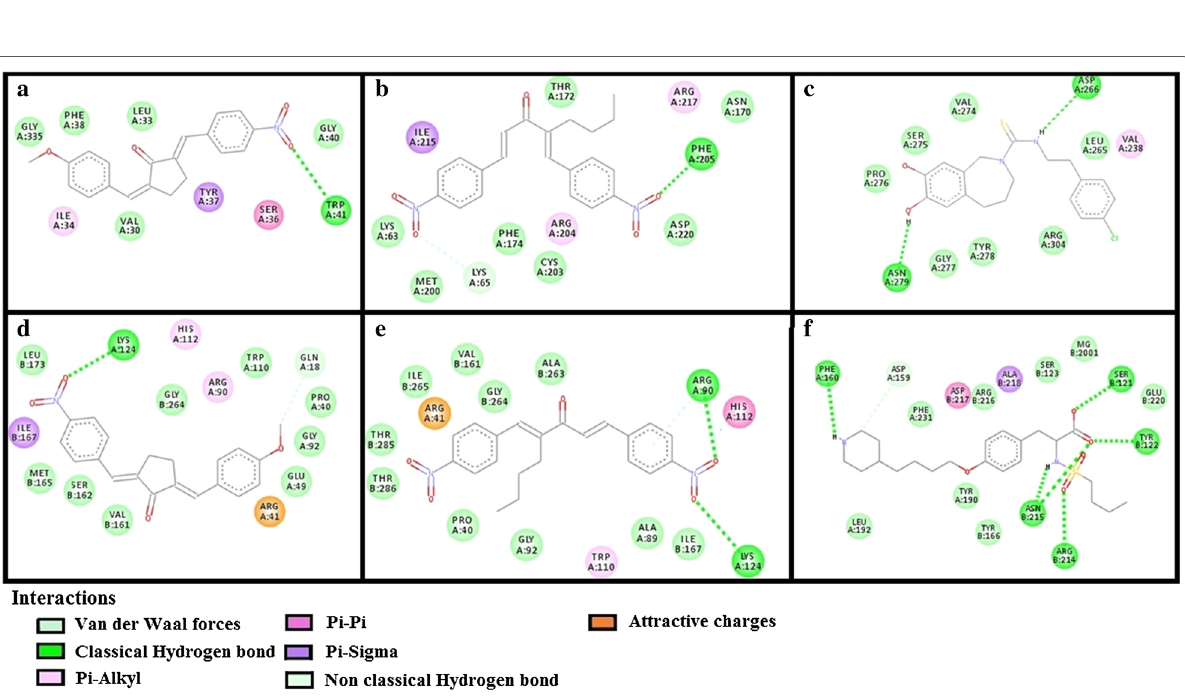
Fig. 7 a – c Represents interactions of ligands: (2 E ,5 E )‑2‑(4‑methoxybenzylidene)‑5‑(4‑nitrobenzylidene) cyclopentanone (AK‑1a), (1 E ,4 E )‑4‑(4‑nitrob enzylidene)‑1‑(4‑nitrophenyl) oct‑1‑en‑3‑one (AK‑2a) and capsazepine with target: purinoceptor‑3 (P2X3) respectively. d – f Represents interactions of AK‑1a, AK‑2a and tirofiban with target: glycoprotein‑IIb/IIIa (GP‑IIb/IIIa) respectively, drawn through Biovia Discovery Studio Visualizer client